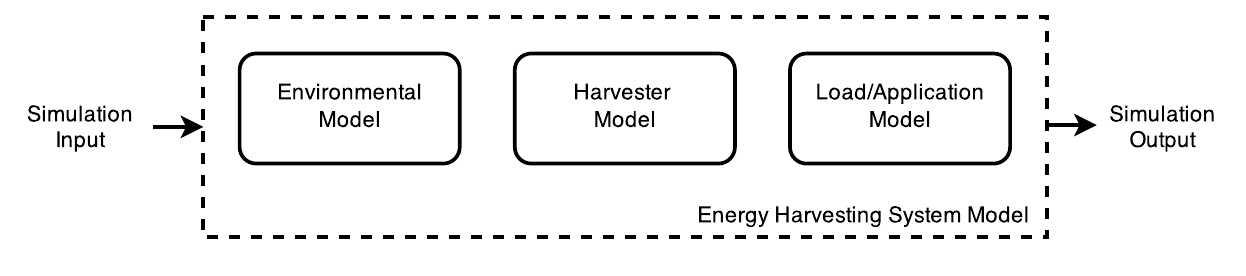
Figure 2. Overview of the model components for an energy harvesting system